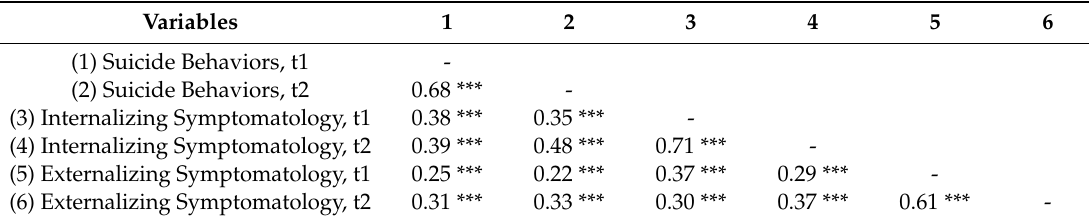
Table 2. Bivariate correlations between